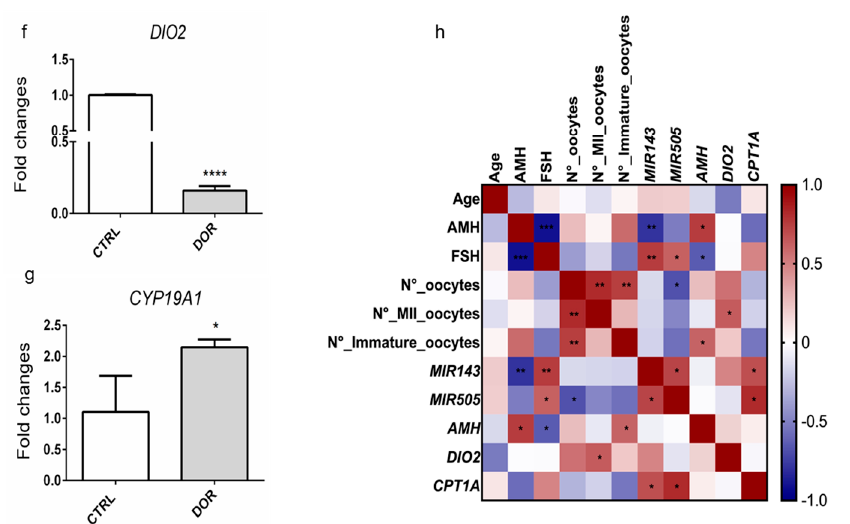
Figure 6. TH variation in FF and CCs of women with DOR. ( a – c ) Hormones levels (fT4, fT3, E2) detected by ELISA assay in FF from DOR-affected and healthy women. ( d , e ) AMH mRNA and MIR505 levels were tested by RT-qPCR. Data are reported as the ratio between mRNA/miRNA content DOR and control groups normalized to GAPDH/U6 . ( f , g ) Expression of the genes ( DIO2 and CYP19A1 ) detected by RT-qPCR. ( h ) Spearman’s rank correlation is indicated in color depth (number ranger from − 1 to +1). Data are reported as fold change values calculated as a ratio between average relative gene expression in 5 pz per control group and 7 pz DOR-affected. Significant differences are indicated with * p < 0.05, ** p < 0.01, *** p < 0.001, and **** p < 0.0001 using Student’s t -test.